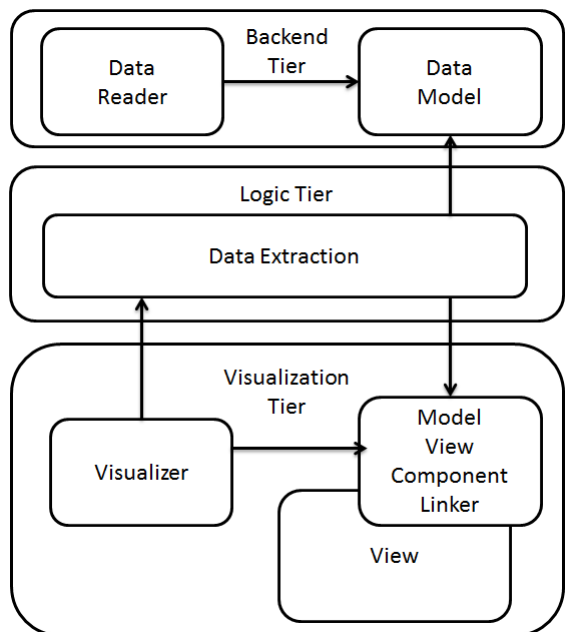
Figure 1: The three-tier structure for reading, extracting, and visualizing network data